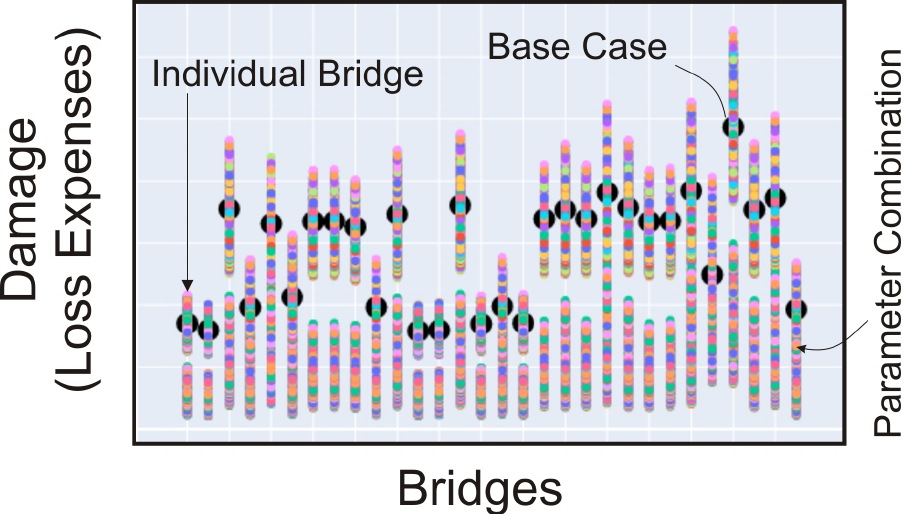
Figure 5. Sensitivity analysis